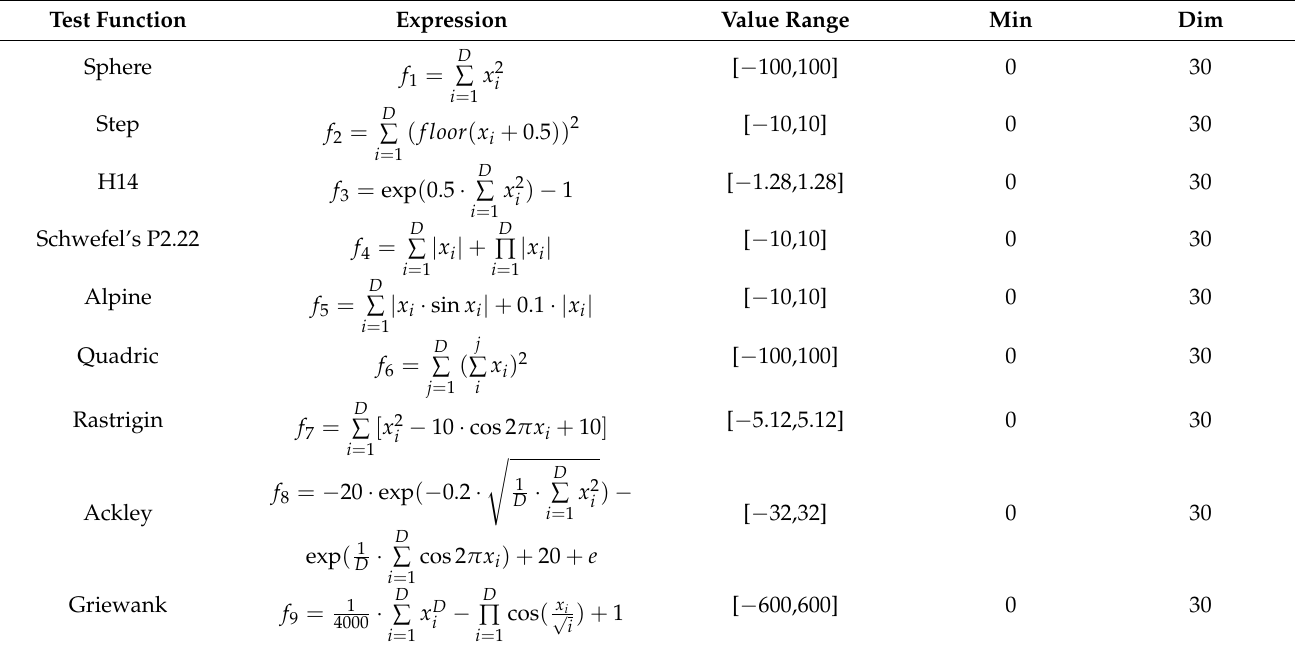
Table 1. Performance of IPSO-IDE with other algorithms based on test